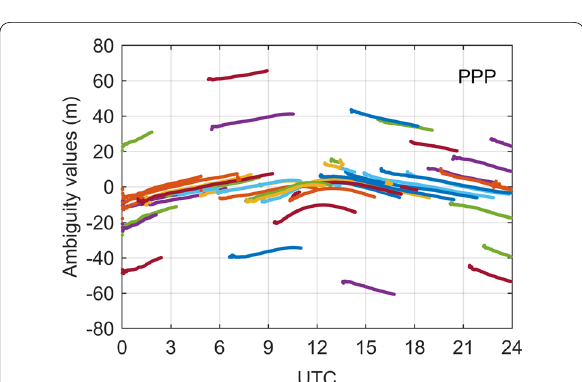
Fig. 3 Estimated ambiguity parameters of L1 frequency at station MTDN using the original PPP model. Different colors correspond to different